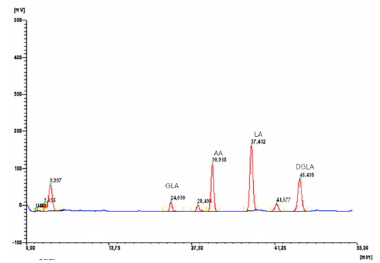
Figure 5. Exemplary HPLC chromatogram of unsaturated fatty acids: GLA, LA, AA, DGLA in microsomal fraction. The highest AA increase (~0.44 mg/100 mg protein) was observed in CON group, whereas the lowest in the PSO + BME group (~0.32 mg/100 mg protein) (Figure 6C). The highest D6D index, expressing the enzyme activity, was observed in microsomes obtained from CON group (2.91 × 10 − 3 ) (Figure 6A). Conversely, both PSO and BME significantly decreased D6D index in comparison with the CON group. In the case of D5D activity, its value was significantly lower in comparison with the CON group only in the BME and PSO + BME groups (Figure 6B). The supplementation with PSO did not significantly affect the activity of the examined enzyme.